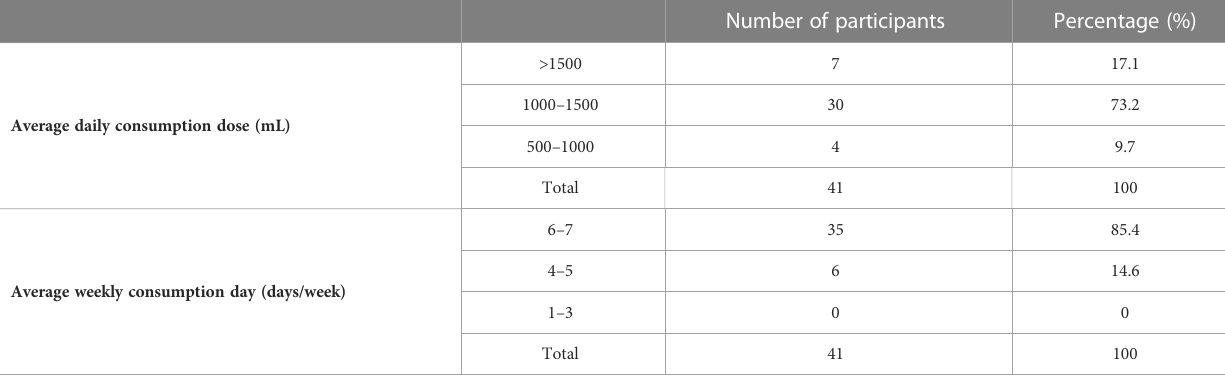
TABLE 2 Actual consumption dose and days in the intervention group.